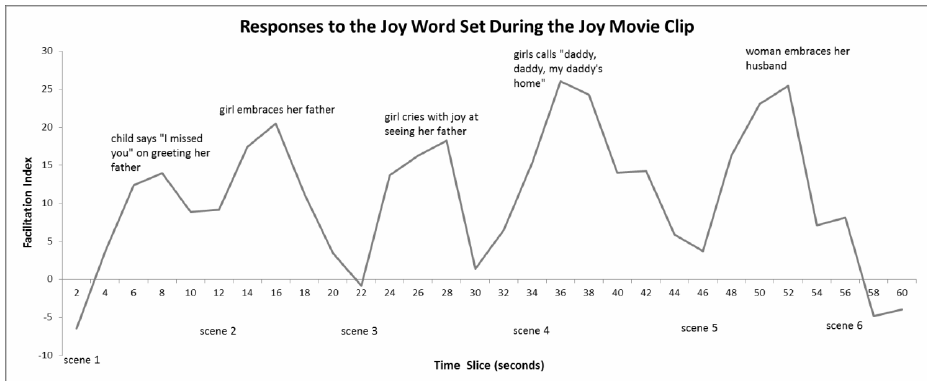
Figure 1. Three-point moving averages of facilitation indices for the Joy word set whilst viewing the Joy movie clip. Positive scores imply participants were experiencing joy, negative scores imply they were experiencing the opposite (sadness). The start points of each of the six scenes are indicated, as well as their peak indices and a brief description of the content at that point in time. Analysis indicated that the facilitation indices at the seconds 8, 14, 16, 24 – 28, 34 − 38, and 48 − 52 (all of the peaks) are significantly di ff erent from zero (in each case p < 0.05). Table 2. Explicit responses: emotion ratings for each clip.